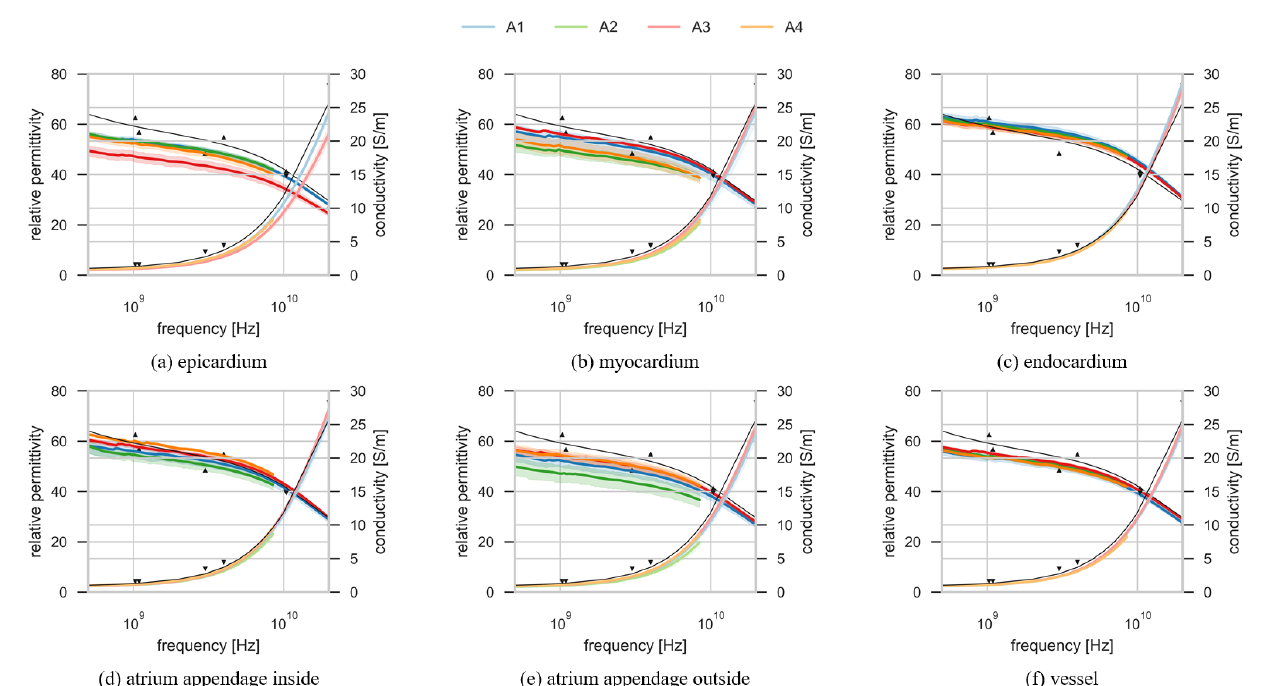
Figure 4. Dielectric properties of six parts of the heart ( a – f ). Each plot shows relative permittivity and conductivity for one part of the heart, measured on four hearts. Four colors correspond to four hearts: A1 is blue, A2 is green, A3 is red and A4 is orange. Darker lines are relative permittivity and lighter lines are conductivity. The measurement results plotted with the green and the orange lines are measured with the E5063A VNA. The measurement results plotted with the blue and red line are representing the measurements performed with the E8362B VNA. Each line is plotted with the corresponding mean ± 2 standard deviations confidence interval. The thin black lines are the model for the relative permittivity and conductivity of the heart muscle from the literature [10–12,51]. The model is based on the data from experimental studies on several different species. The triangle markers are the data points from measurements on human tissues [14].